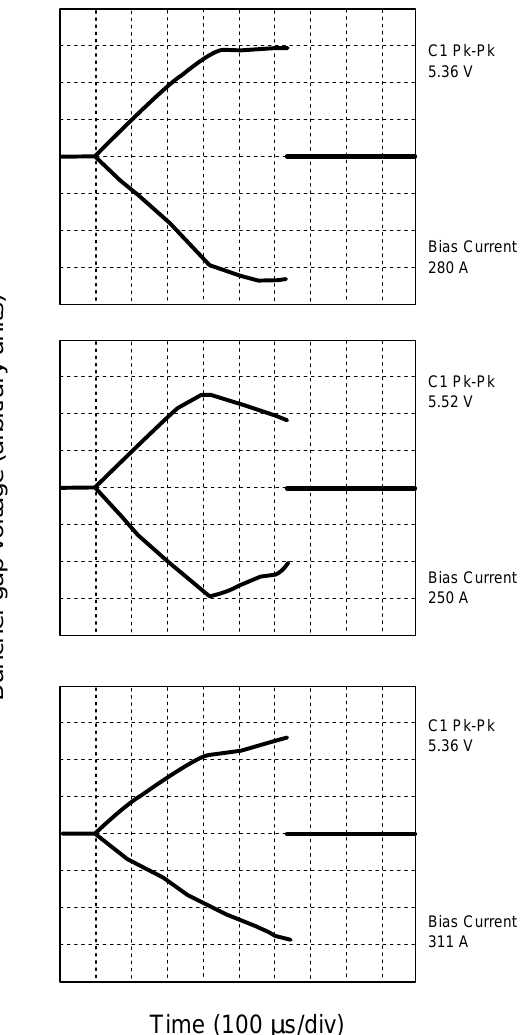
FIG. 2. Beam induced rf voltage on the LANL PSR 2.8 MHz cavity during the injection and storage of the beam. The envelope of the induced rf voltage is shown in arbitrary units, the time scale is 100 m s per division. The start of injection is at about 80 m s, the end of injection oc- curs at approximately 400 m s, and extraction occurs at ap- proximately 620 m s (accounting for the rapid drop in rf